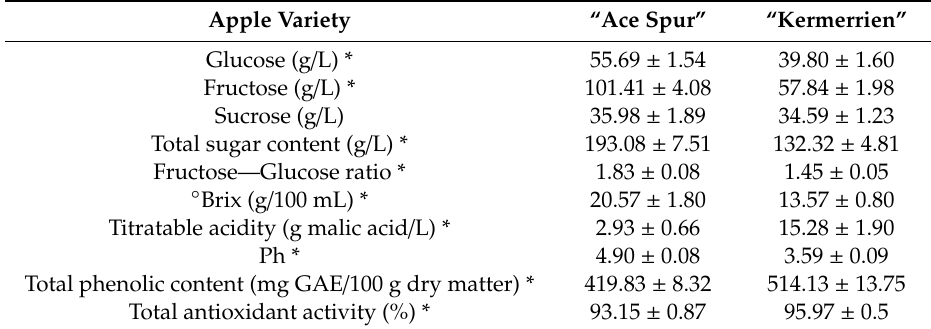
Table 2. Physicochemical apple juice composition of “Ace spur” and “Kermerrien”